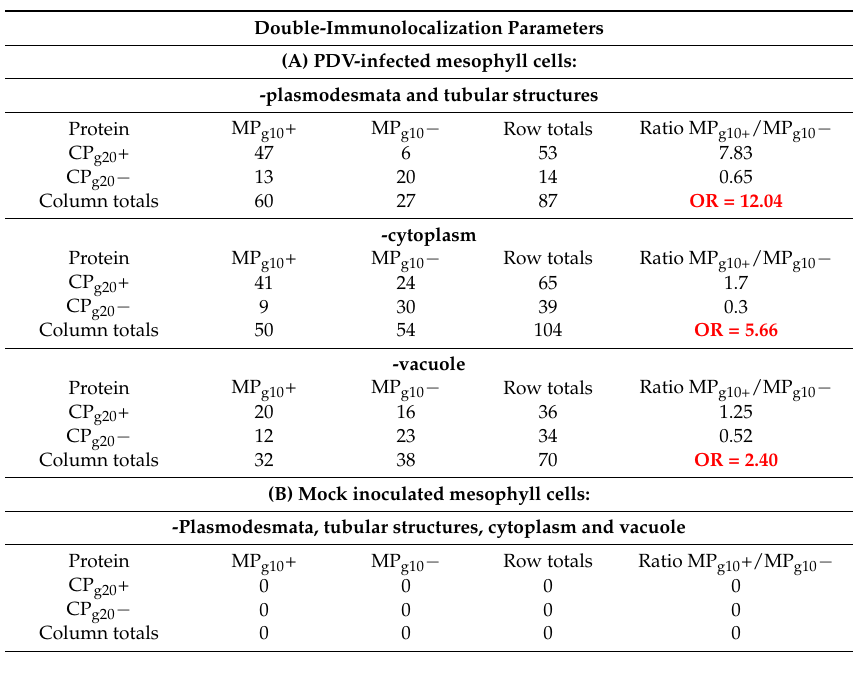
Table 1. Quantification of preferential double-immunogold localization of CP and MP in 2 × 2 contingency tablefromGraphPadSoftware. (A)Quantificationofdouble-immunolocalizationparametersinPDV-infected cucumber leaves. Two-tailed p value ( p ) for cell segments analyses was less than 0.0001. (B) Quantification of double-immunolocalization parameters in mock-inoculated cucumber leaves. No localization was observed. OR—odds ratio, CP g20 +—presence of 20 nm gold particles associated with presence of CP epitope, CP g20 − —absence of 20 nm gold particles associated with presence of CP epitope, MP g10 +—presence of 10 nm gold particles associated with presence of MP epitope, MP g10 − —absence of 10 nm gold particles associated with presence of MP epitope. In table bold and red color value is result of statistical analyses of Quantification of preferential double-immunogold